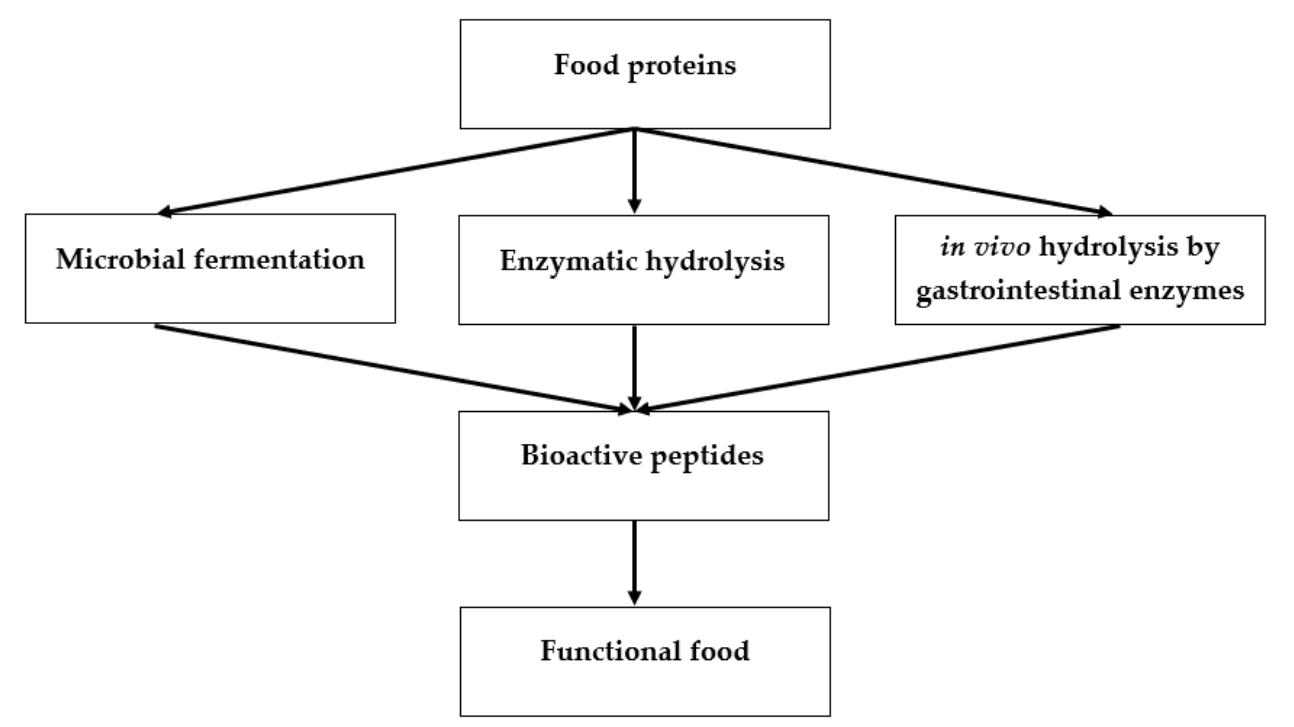
Figure 1. Production of bioactive peptides [1].